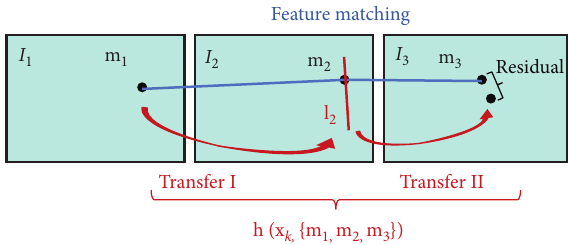
Figure 3: Illustration of predicting the visual measurement using